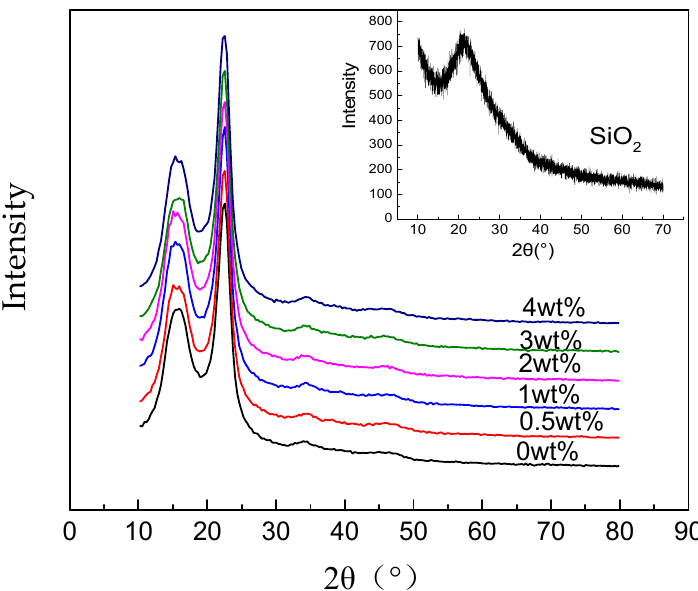
Figure 3. XRD (X-ray diffraction) spectra of non-modified and nano-SiO 2 modified RIP (epoxy resin-impregnated insulation paper).